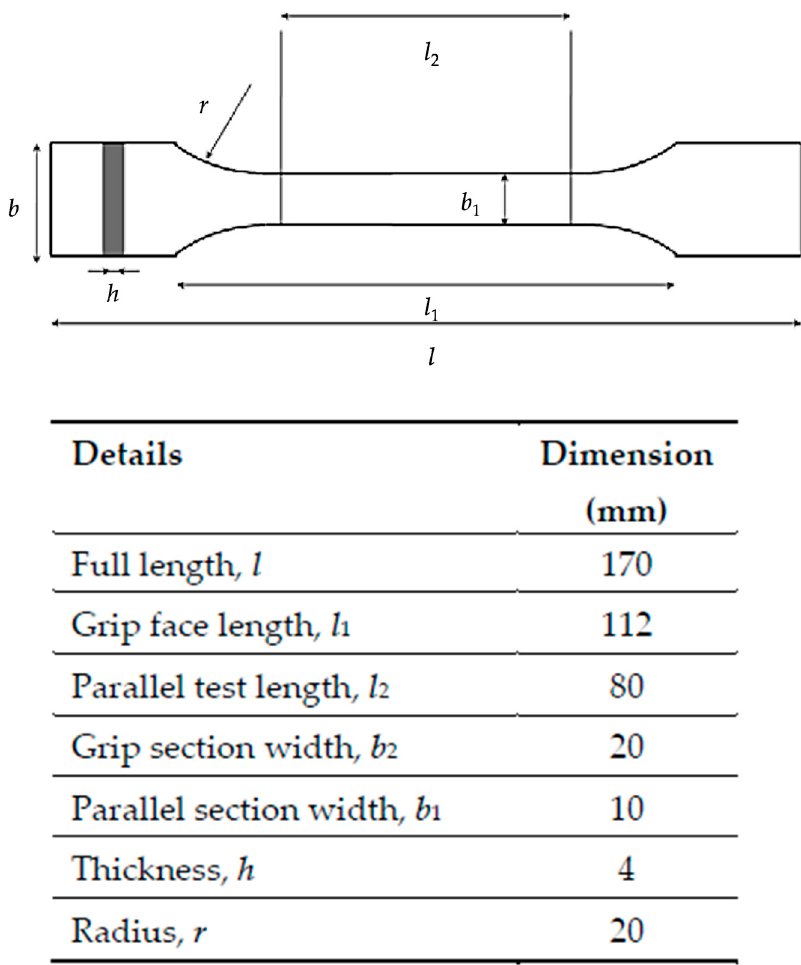
Figure 2. Dimensional specifications of the specimen according to ISO 527-1:2012 [23,25].